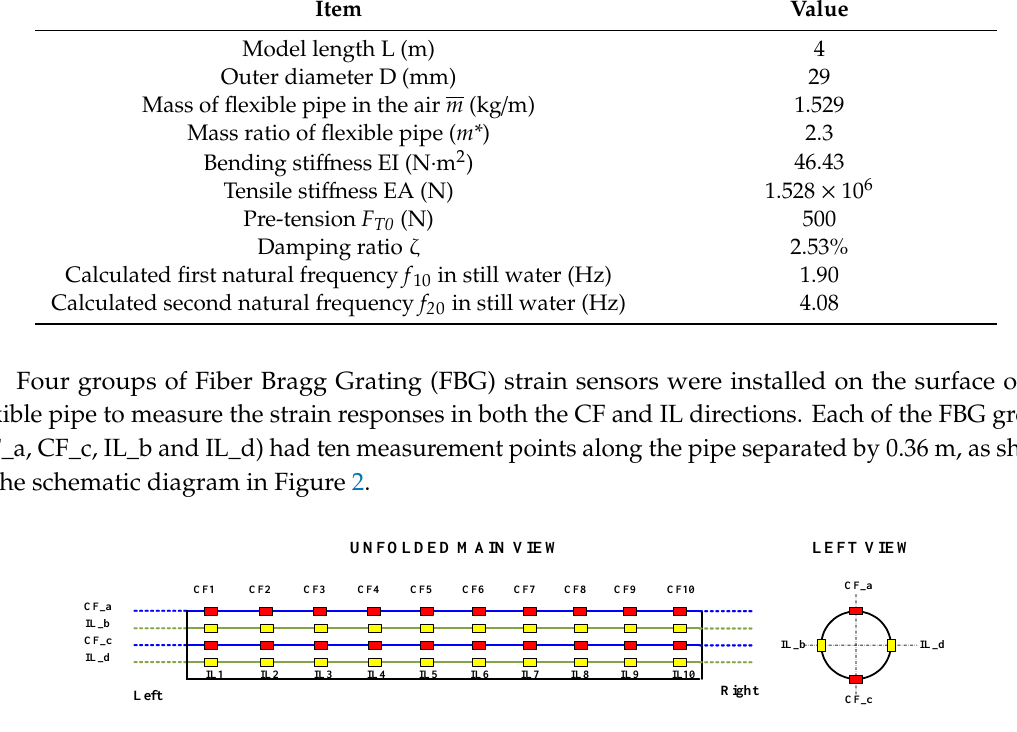
4 of 24 Figure 1. Overview and sketch of the whole experimental setup: (a. the overview photo; b. the schematic drawing). The flexible pipe was made up of a polypropylene random pipe that is filled with copper cable inside. Silicone gel was placed between different layers to prevent relative slippage. The details of the flexible pipe are listed in Table 2. The bending stiffness is 46.433 N•m 2 and the damping ratio is 2.53%. The 1st and 2nd order eigen frequency of the flexible pipe in still water can be calculated by which can be calculated by Equation (1) . 𝑓 𝑛0 = 𝑛 2𝐿 √ 𝐹 𝑇0 𝑚 + 𝑛 2 𝜋 2 𝐿 2 ⋅ 𝐸𝐼 𝑚 , 𝑚 = 𝑚̅ + 1 4 𝜋𝐷 2 𝜌𝐶 𝑚 ,